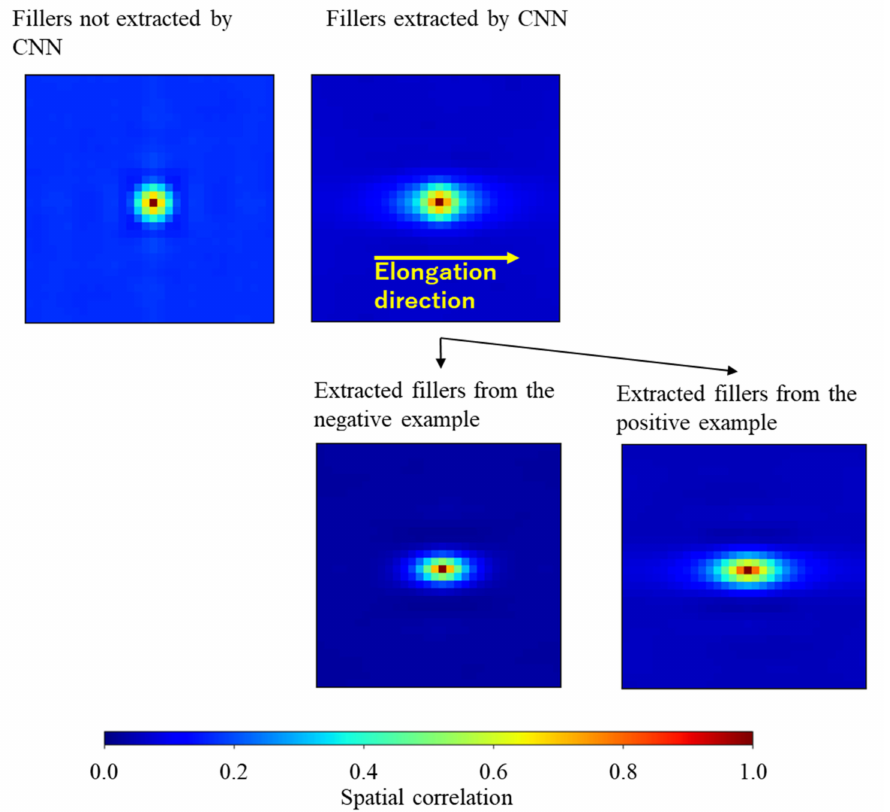
Figure 20. Spatial correlations in the YZ plane of r -space including r = ( 0,0,0 ) of the CNN-extracted fillers from all morphology examples that contribute to the high stress and that of the non-extracted fillers (upper row figures). The isotropic spatial correlation of the fillers not extracted by the CNN suggests the isotropically shaped filler aggregates. Meanwhile, the anisotropic spatial correlation of the filler particles extracted by the CNN indicates that the probability of filler orientation along the elongation direction is high. Furthermore, bottom two figures show the spatial correlations of the extracted fillers from all positive examples and all negative examples, respectively. The higher orientation probability of the filler particles extracted from the positive example along the elongation direction suggests that the aggregate size measured along the elongation direction in the positive example is larger than the size of the negative